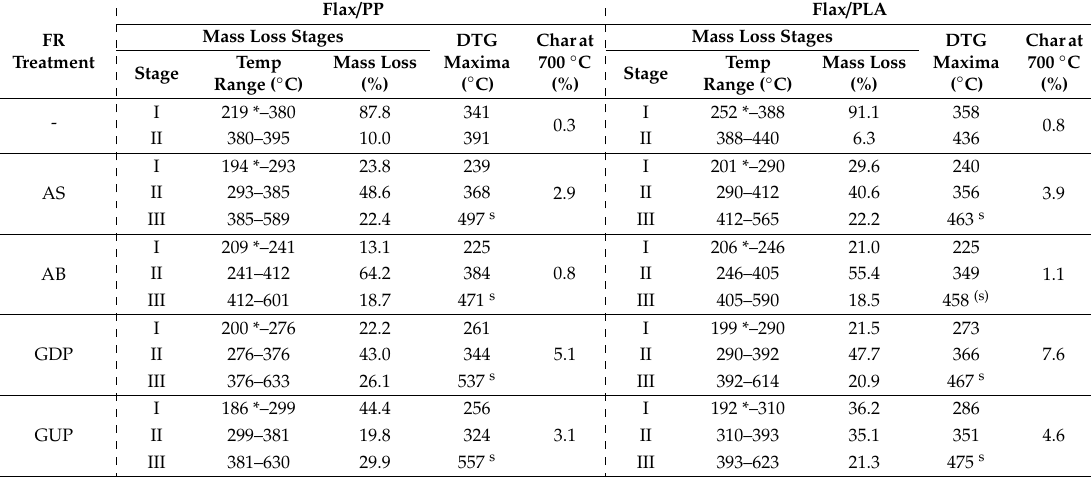
Figure 3. TGA curves of control and FR treated ( a ) flax/PP and ( b ) flax/PLA composites in air. Table 4. TGA and DTG results of unmodified and fire retarded flax/PP and flax/PLA composites in air.